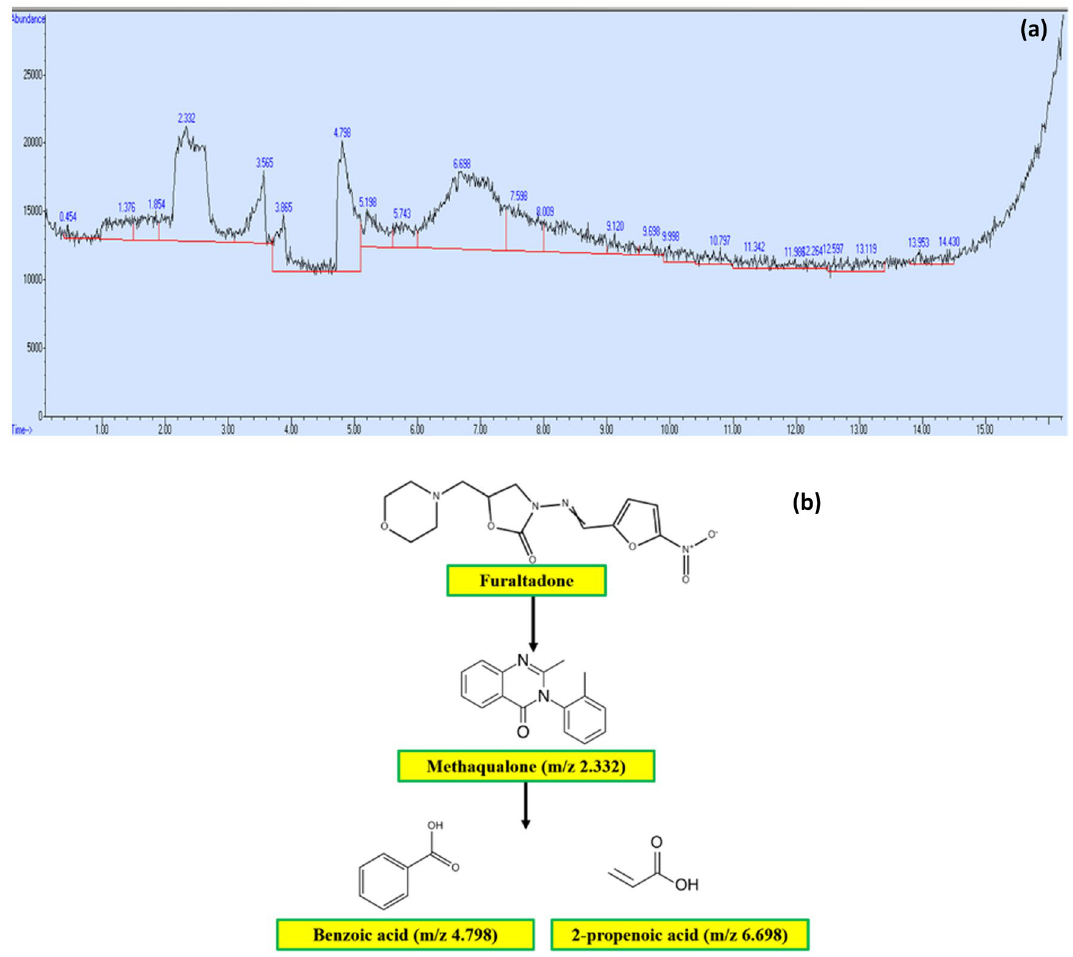
Figure 15. ( a ) GC chromatogram of FLT showing degradation and degradation products, and ( b ) proposed degradation pathway depicts the intermediates after photocatalytic degradation of